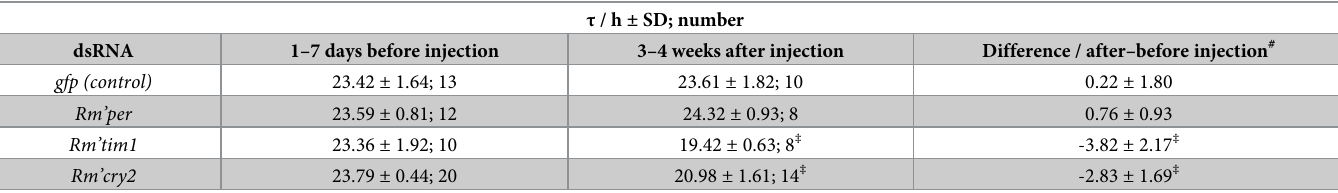
Table 1. Periods ( τ )of free-running locomotor activity